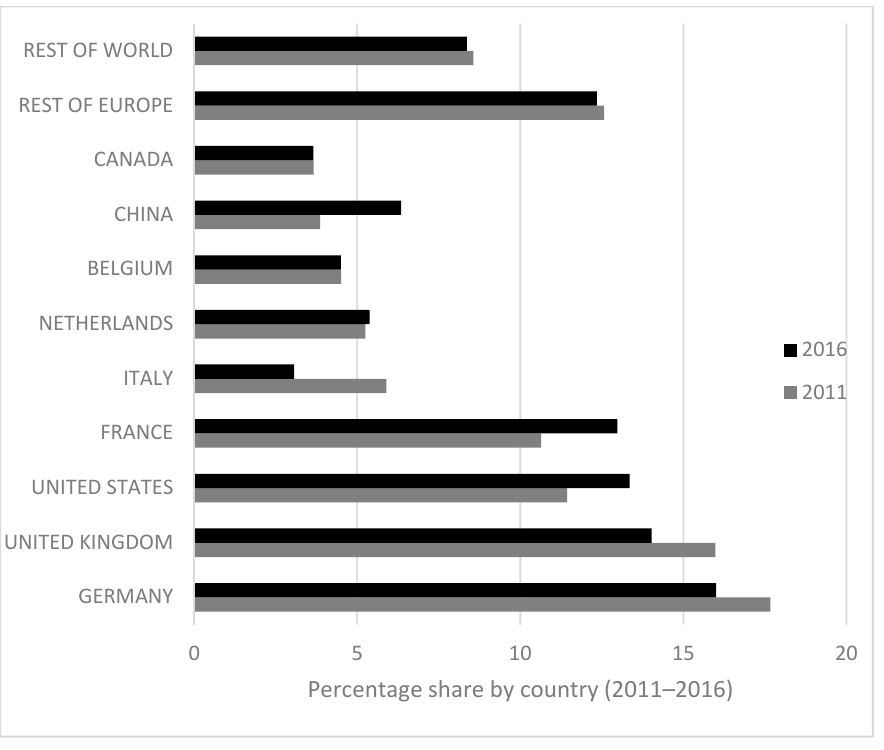
Figure 3. Percentage share by country of the carbon footprint generated by Spanish wine exports (2011–2016).